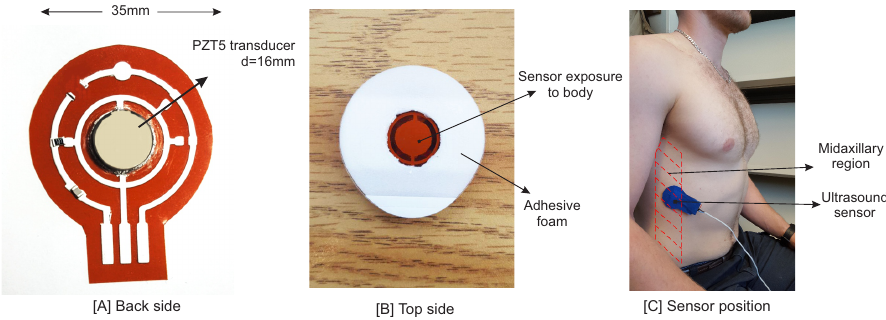
Figure 1. ( A ) The PZT5 piezo transducer mounted on a flexible printed PCB circuit. ( B ) The top side of the sensor. A two-sided adhesive pad is used to hold the sensor on the body. The middle round area is filled by ultrasound gel. ( C ) Sensor position in the zone of apposition (ZOA). The sensor on the back side is covered by a blue